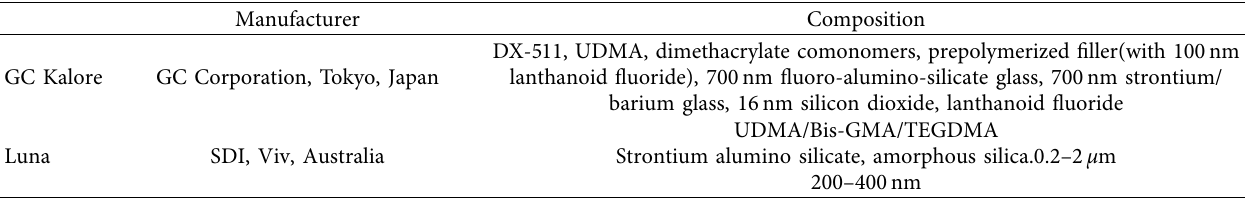
Table 1: Materials used in this